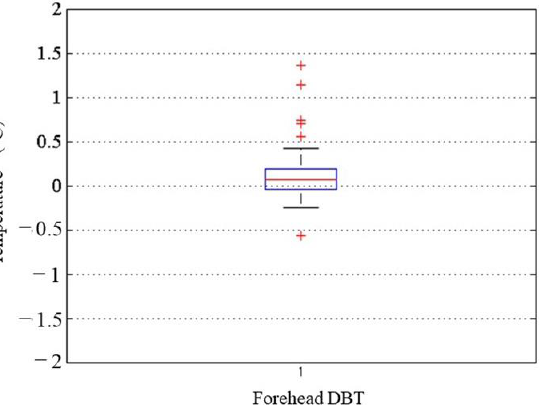
Figure 10. Box plot of DBT during the exercise and recovery periods. DBT measured on the forehead by the ZHFT and DHFT.